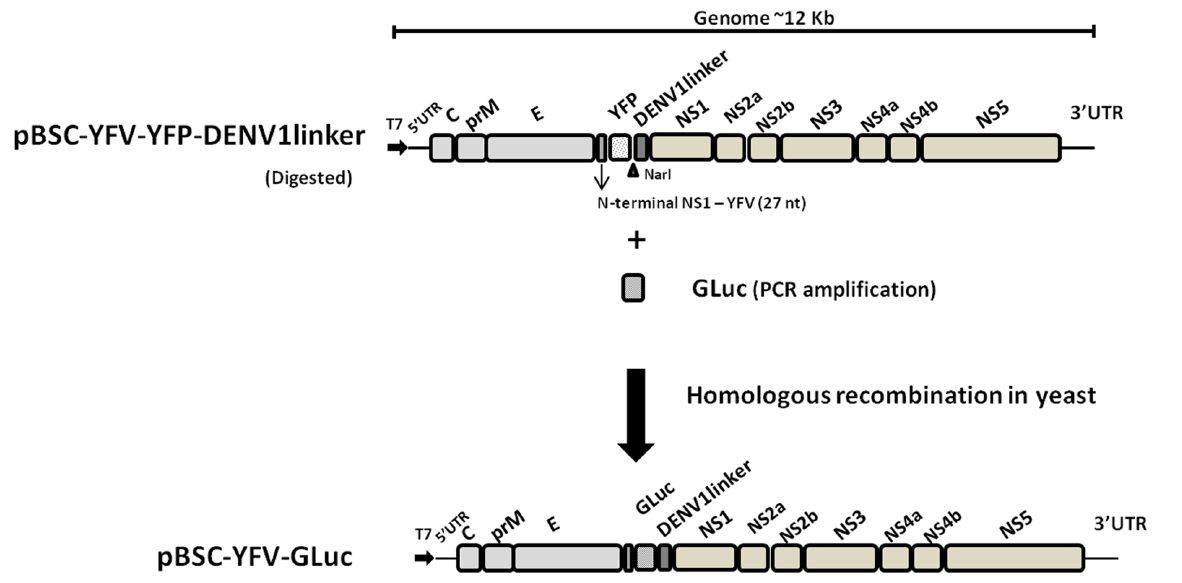
(Table I). The full-length PCR conditions were as follows: initial denaturation at 95°C for 5 min; 32 cycles of denaturation at 93°C for 1 min, annealing at 56°C for 1 min, and extension at 72°C for 13 min, with an increase of 10 s in extension per cycle;